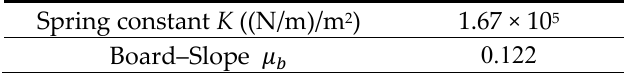
Table 3. Parameters for the linear spring